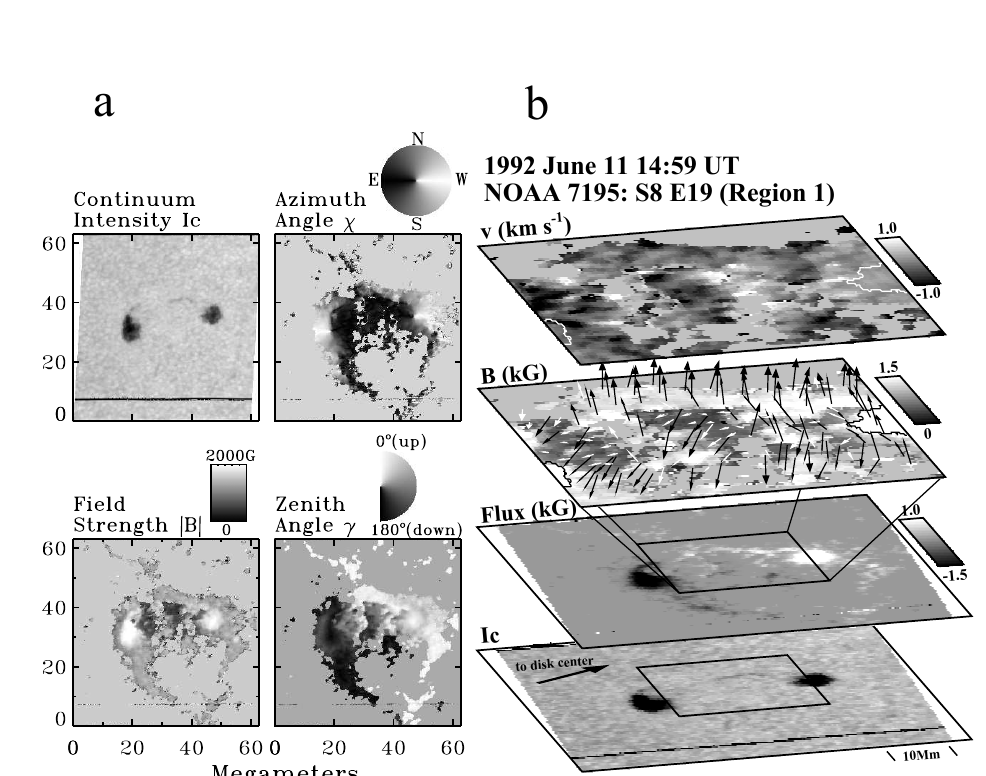
Figure 2: Vector magnetic fields of an emerging bipolar AR: (a) from upper left corner clockwise: con- tinuum intensity, azimuth angle, zenith angle, magnetic field strength. (b) Perspective view, from bottom to top: continuum intensity, magnetic flux (white is positive, black is negative), magnetic field vectors, and Doppler velocity (blue-shift is positive). Image reproduced with permission from Lites et al. (1998), copyright by